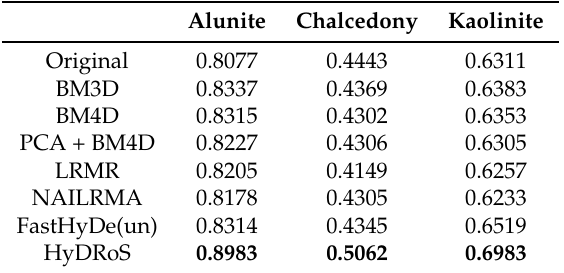
Table 5. AUC obtained by SFF for Hyperion noise-reduced HSI data at Cuprite Mining